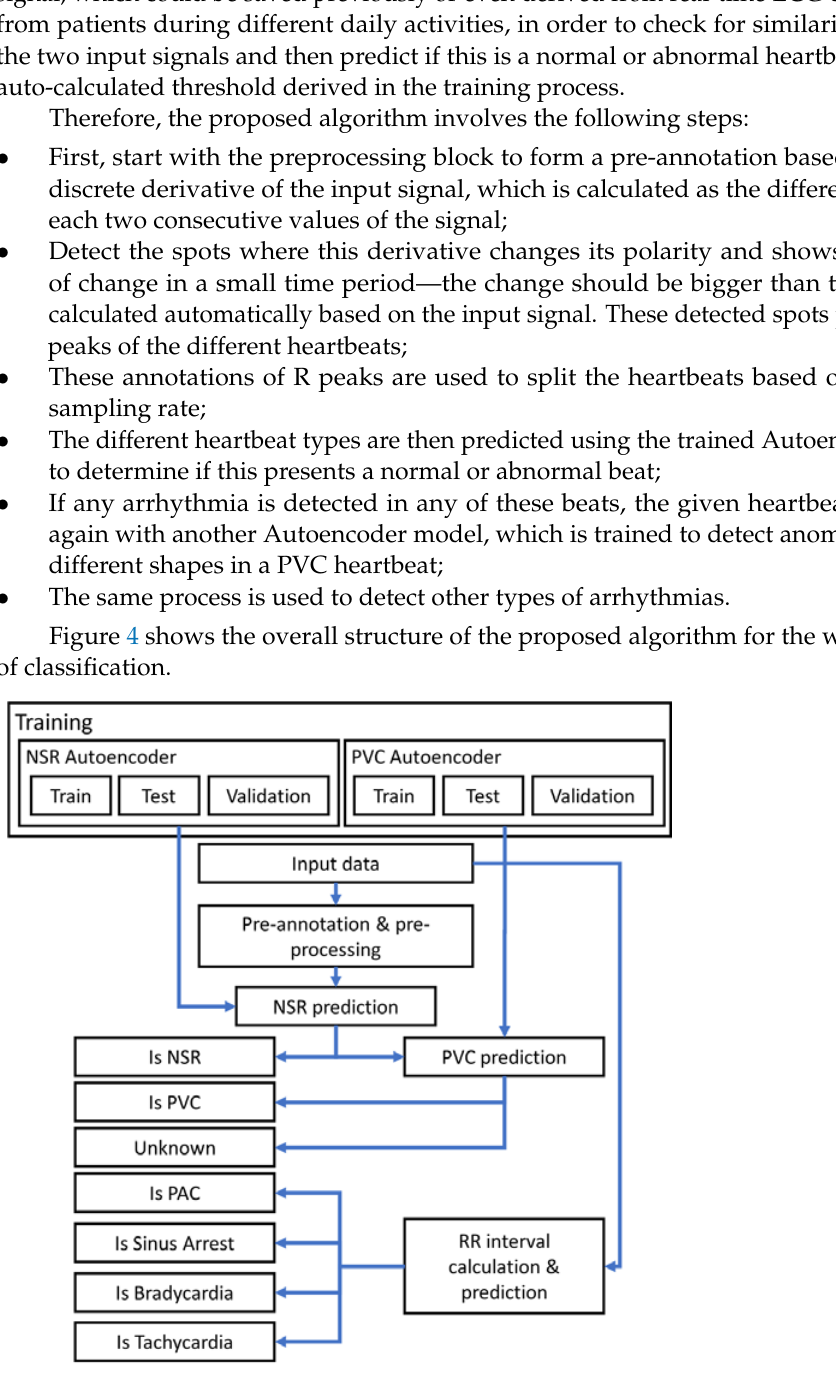
Figure 4. General structure of the proposed algorithm.